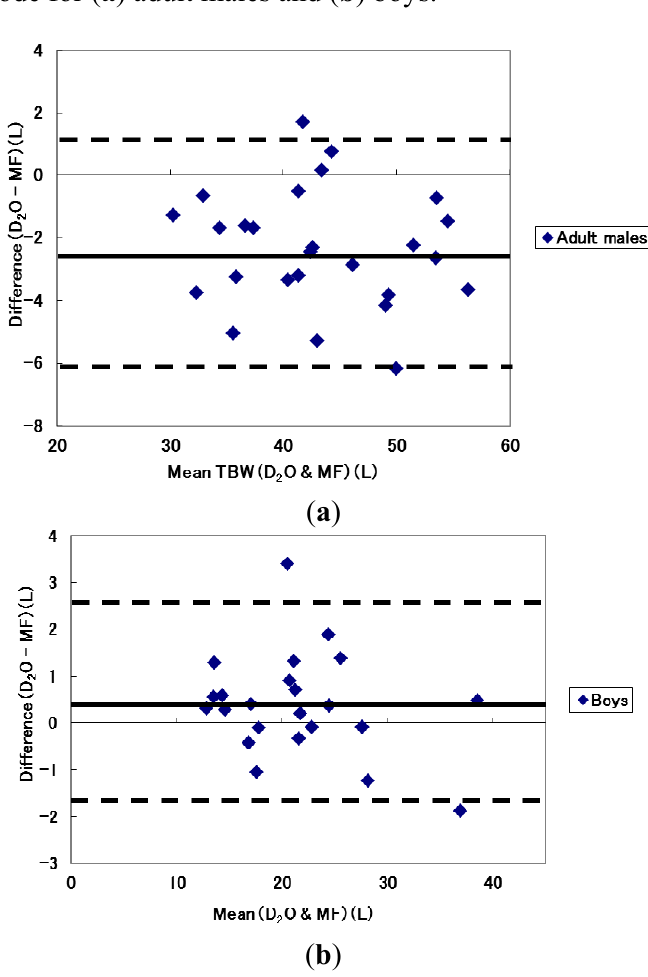
Figure 1. Bland and Altman plots between TBW estimated from the dilution technique and multi-frequency mode for ( a ) adult males and ( b ) boys.